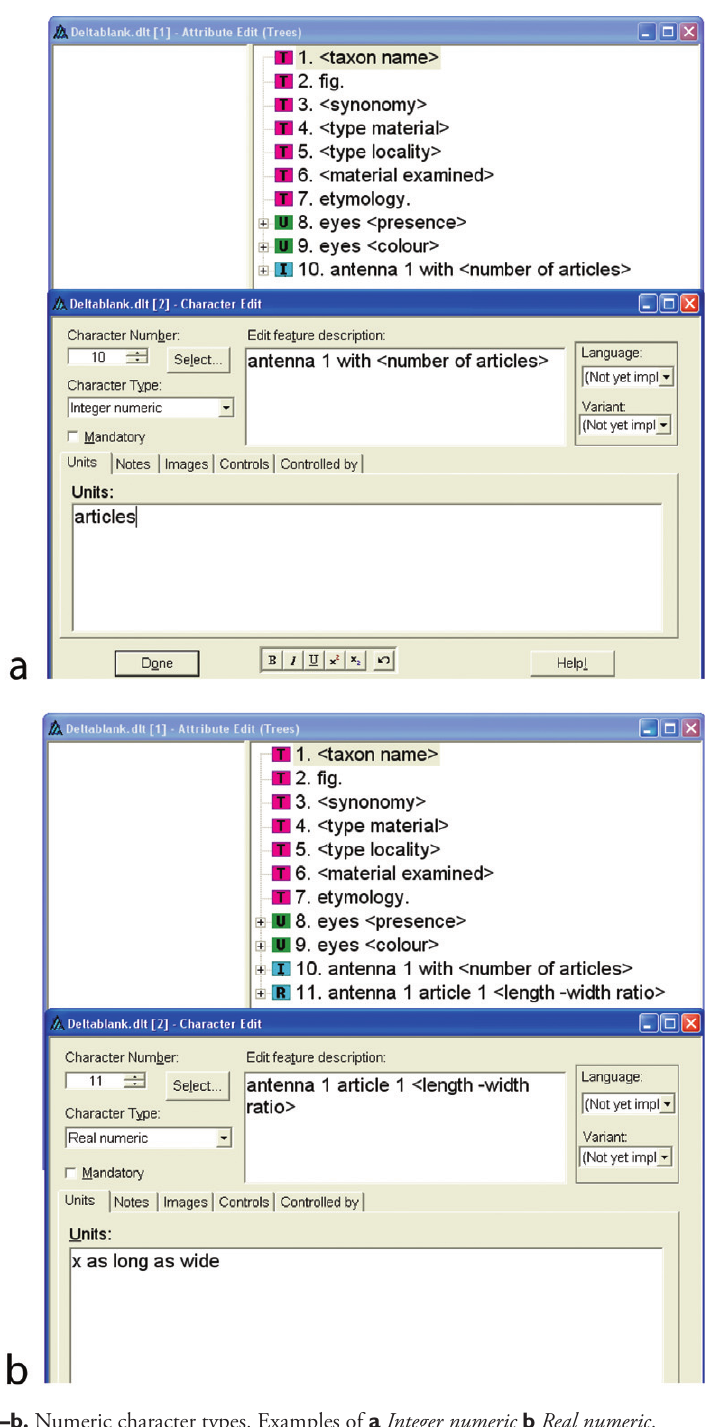
Figure 9a–b. Numeric character types. Examples of a Integer numeric b Real numeric